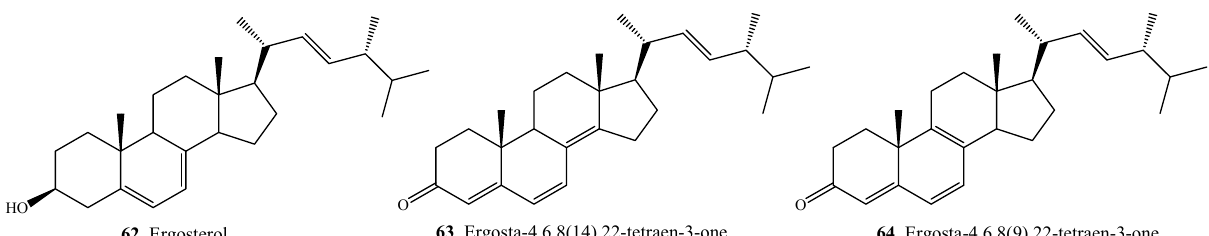
Figure 4. Steroids isolated from Alternaria